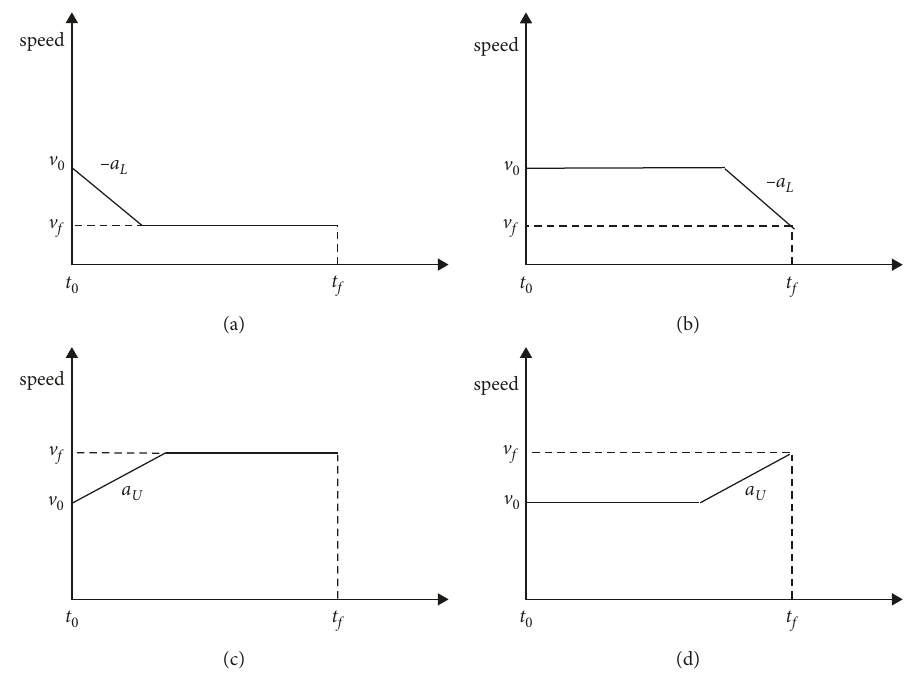
Figure 4: The two-segment trajectory when the travel time is equal to the boundary values. (a) t